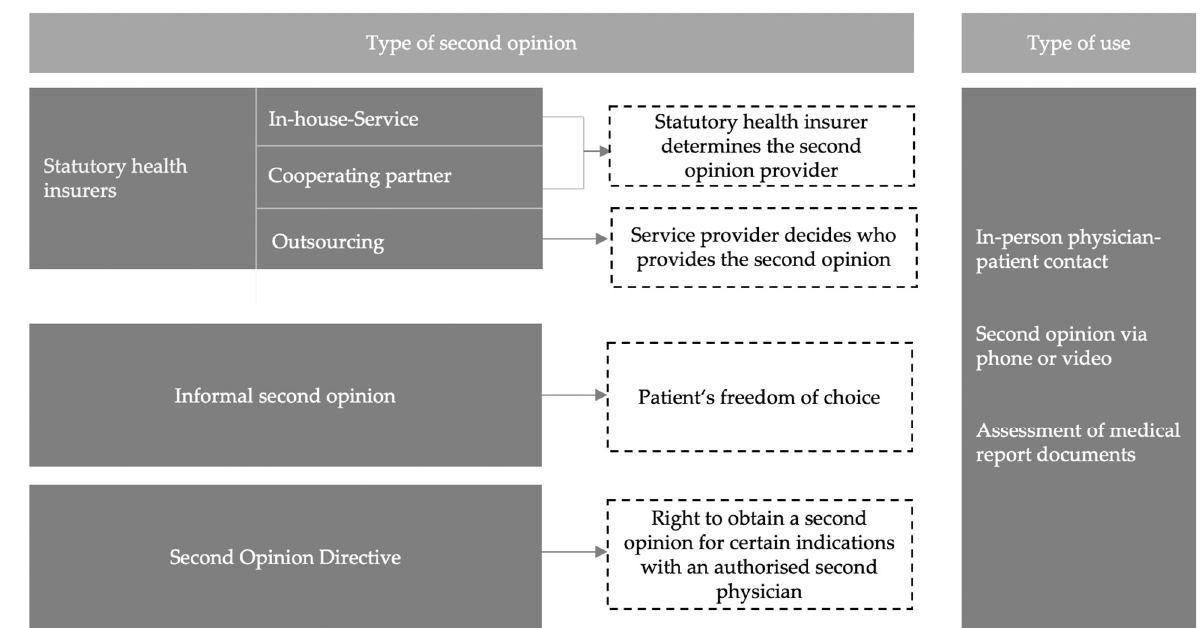
Figure 1. Options for obtaining a second opinion in Germany in accordance with Pieper [5].